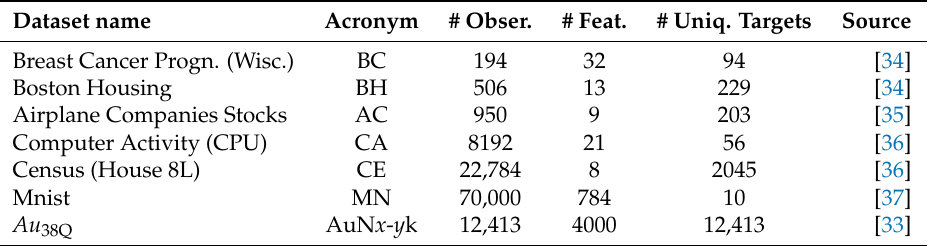
Table 2. Datasets